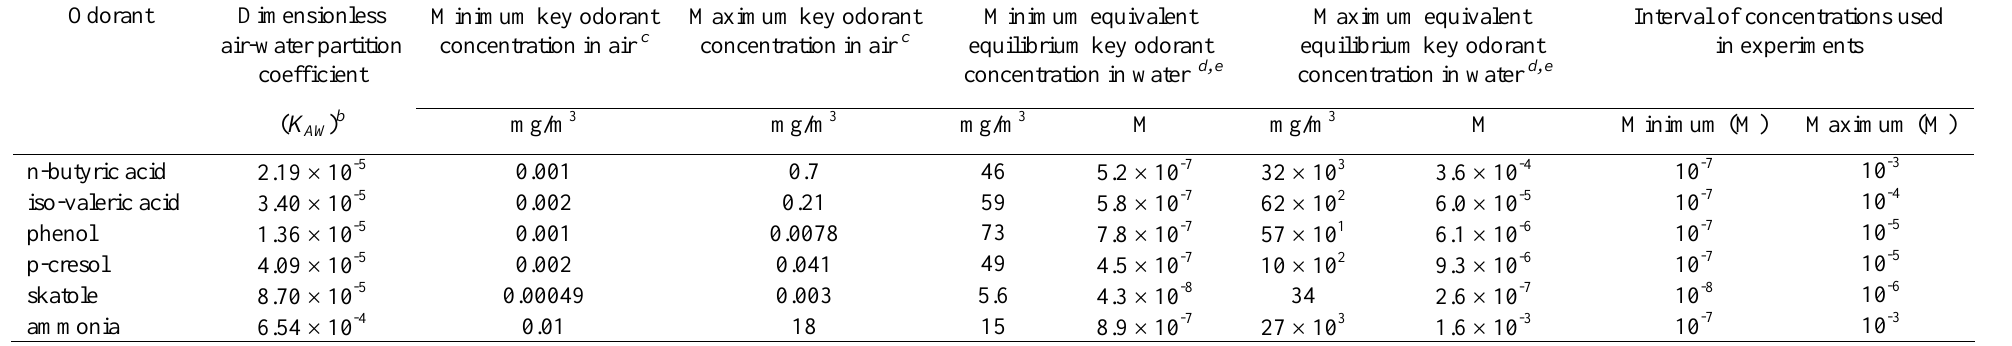
Table 2: Concentration of key odorants in air and water.